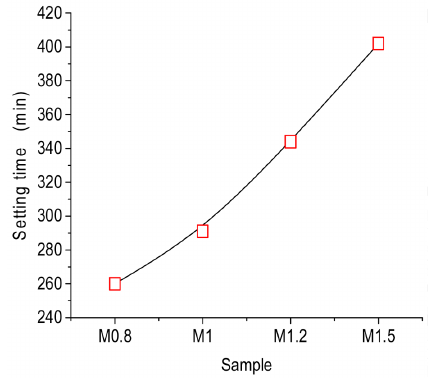
Figure 5. Effect of SiO 2 /Na 2 O ratio on final setting time of the geopolymer coating.